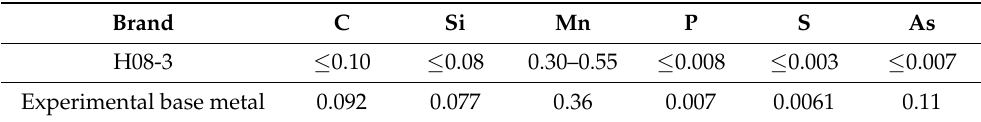
Table 1. Typical steel standard chemical composition of special welding materials for weathering and cryogenic vessels, and the material composition selected in this experiment